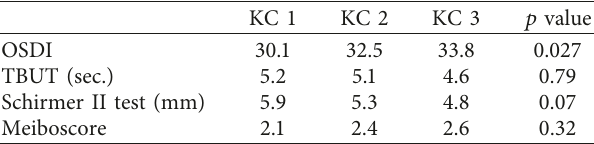
Table 2: Clinical findings in different keratoconus